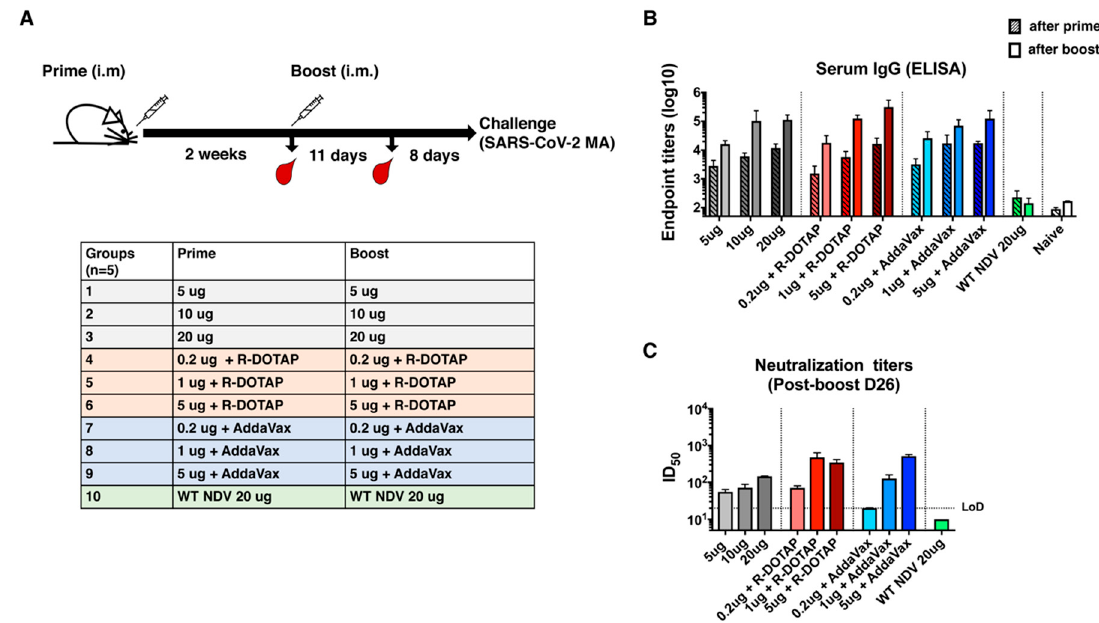
Figure 3. Inactivated NDV-S vaccine elicits high antibody responses in mice. ( A ) Immunization regimen and groups. BALB / c mice were given two immunizations via the intramuscular administration route with a 2-week interval. Mice were bled pre-boost and 11 days after the boost for in vitro serological assays. Mice were challenged with a mouse-adapted SARS-CoV-2 strain 19 days after the boost. Ten groups described in the table were included in this study. Group 1, 2, and 3 were immunized with 5, 10, and 20 µ g of vaccine, respectively; group 4, 5, and 6 were immunized with 0.2, 1, and 5 µ g of vaccine formulated with the R-enantiomer of the cationic lipid DOTAP (R-DOTAP), respectively; group 7, 8, and 9 were immunized with 0.2, 1, and 5 µ g of vaccine combined with AddaVax, respectively; and group 10 was immunized with 20 µ g of WT NDV virus as the vector-only control. ( B ) Spike-specific serum IgG titers. Serum IgG titers from animals after prime (pattern bars) and boost (solid bars) toward the recombinant trimeric spike protein were measured by an enzyme linked immunosorbent assay (ELISA). Endpoint titers were shown as the readout for ELISA. ( C ) Neutralization titers of serum antibodies. Microneutralization assays were performed to determine the neutralizing activities of serum antibodies from animals after the boost (D26) using the USA-WA1 / 2020 SARS-CoV-2 strain. The 50% of inhibitory dilution (ID 50 ) of serum samples showing no neutralizing activity (WT NDV) was set as 10 (LoD: limit of detection).